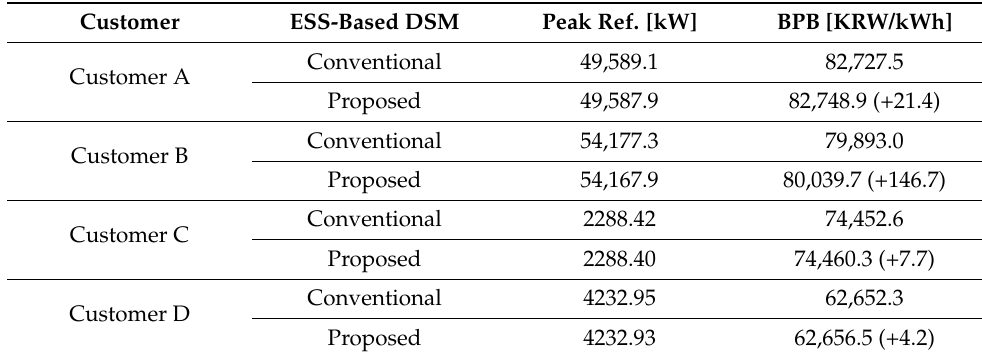
Table 5. Simulation results of the proposed ESS-based DSM for Customers A–D.